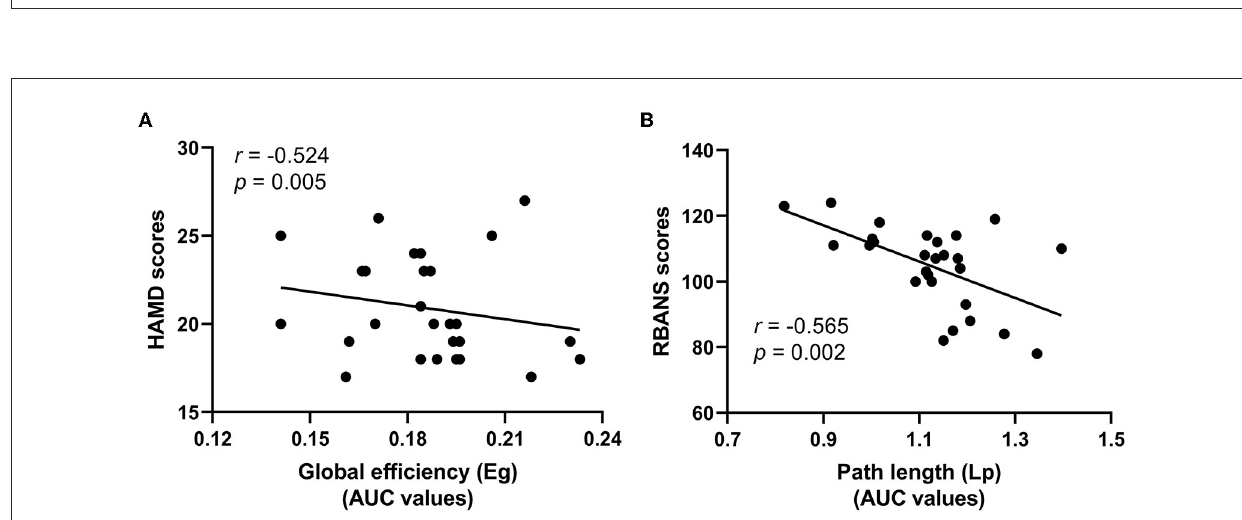
FIGURE4 Correlation analysis of HAMD-17 scores, RBANS scores, and global attribute indicators. (A) The Cc values of functional brain networks were inversely correlated with the scores of HAMD-17 in the LLD baseline group; (B) The Lp values of functional brain networks were inversely correlated with the RBANS scores in the LLD follow-up